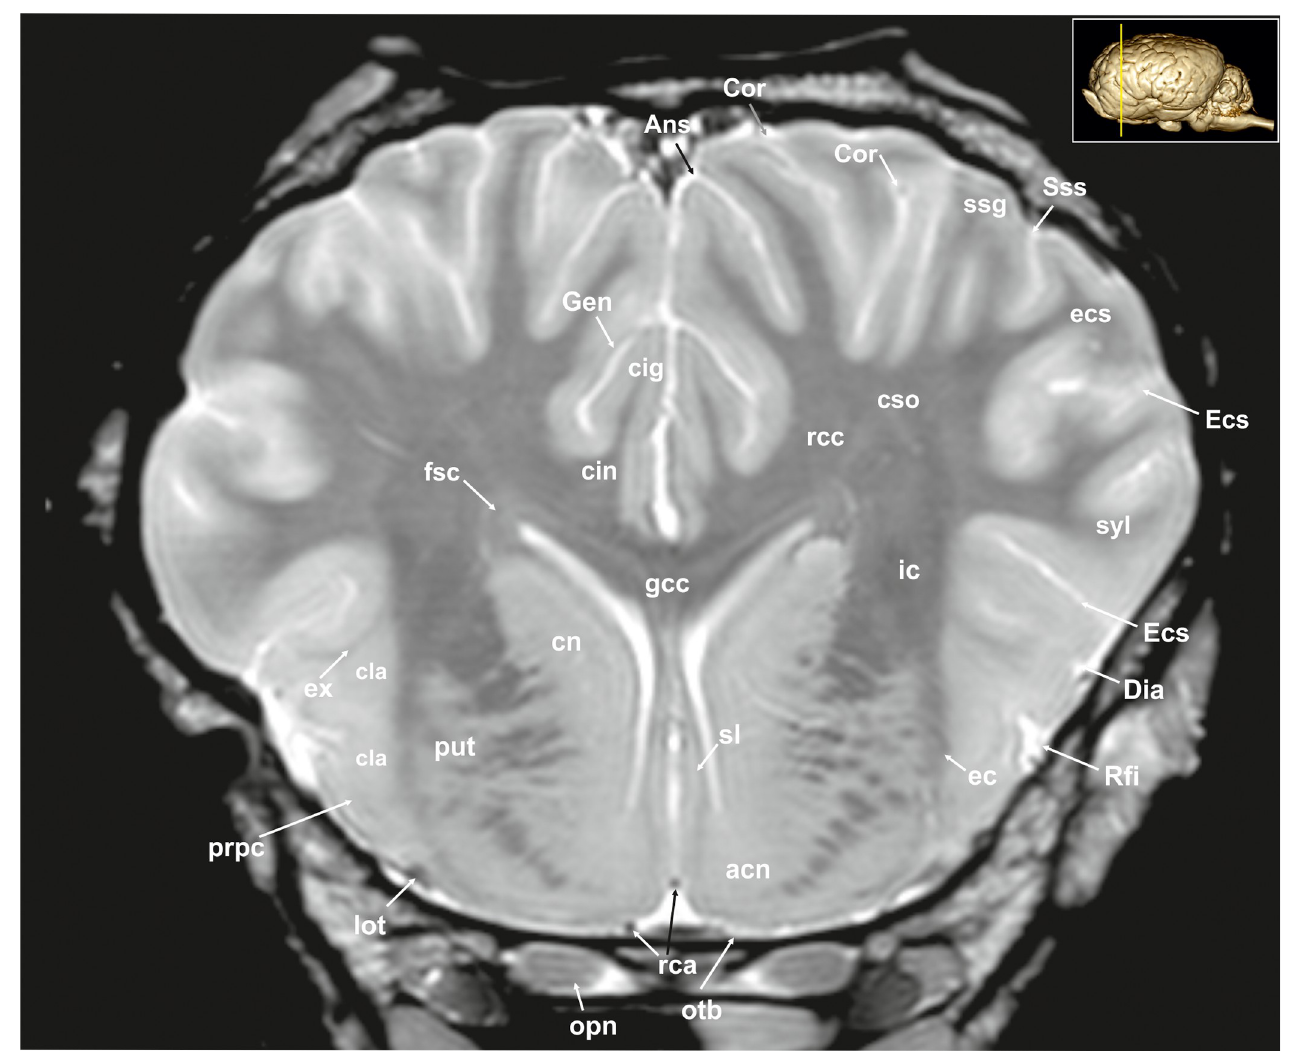
Fig 4. Transverse magnetic resonance image of the equine brain on the level of the septal nuclei. acn: accumbens nucleus, Ans: ansate sulcus, cig: cingulate gyrus, cin: cingulum, cla: claustrum, cn: caudate nucleus (caput), Cor: coronal sulcus, cso: centrum semiovale, Dia: diagonal sulcus, ec: external capsule, ecs: ectosylvian gyrus, Ecs: ectosylvian sulcus, ex: extreme capsule, fsc: subcallosal fasciculus, gcc: genu of the corpus callosum, Gen: genual sulcus, ic: internal capsule, lot: lateral olfactory tract, opn: optic nerve, otb: olfactory tubercle, put: putamen, rca: rostral cerebral artery, rcc: radiation of the corpus callosum, Rfi: rhinal fissure, sl: lateral septal nuclei, ssg: suprasylvian gyrus, Sss: suprasylvian sulcus, syl: sylvian gyrus.